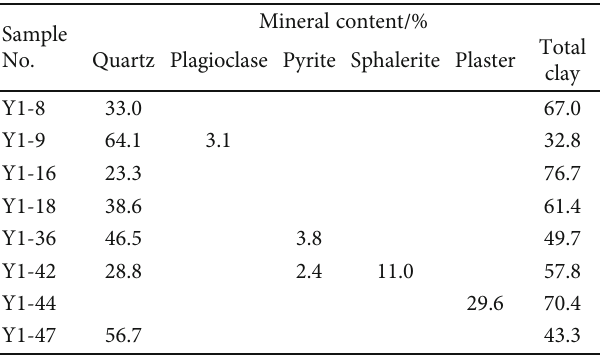
Figure 2: TOC content and percentage of Lower Shihezi Group to Taiyuan Group in Y1 well. Table 2: Mineral composition content of shale gas reservoir in the Lower Shihezi group to the Taiyuan group of well